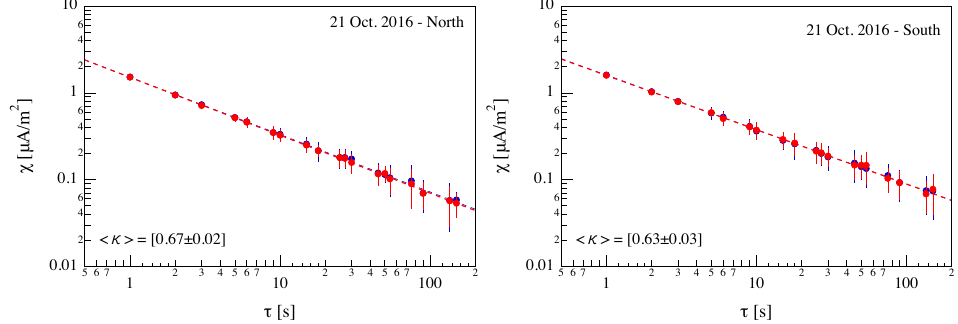
Figure 5. The partition function χ ( τ ) averaged on the Northern and Southern Hemisphere crossings of the polar ionosphere on 21 October 2016. Blue and red solid circles refer to Swarms A and C, respectively. The dashed lines are power-law